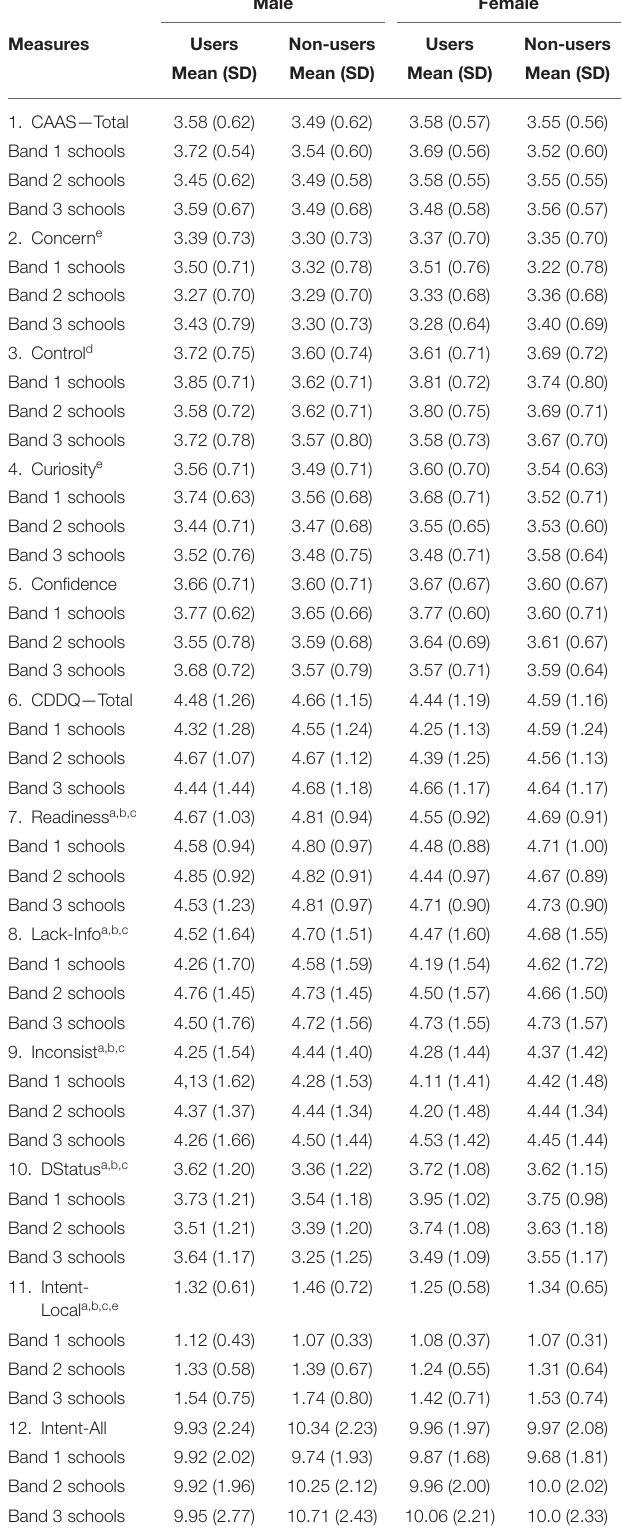
TABLE 5 | Means and standard deviations of career development measures of participants who were users of infinity and non-users. Male